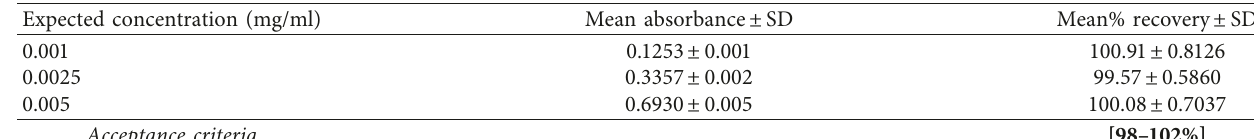
Table 4: Results showing accuracy of results from the developed method.